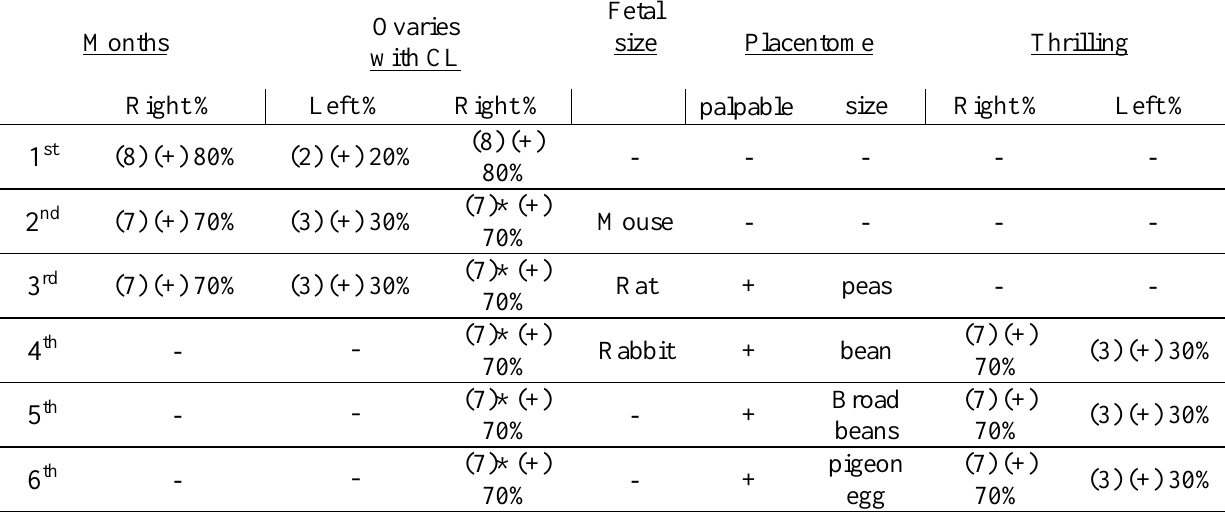
Table 1. Characteristics of pregnancy (ovaries, corpus lutein, fetal size, placentome and thrilling) by rectal palpation according to month of pregnancy in local Iraqi buffaloes